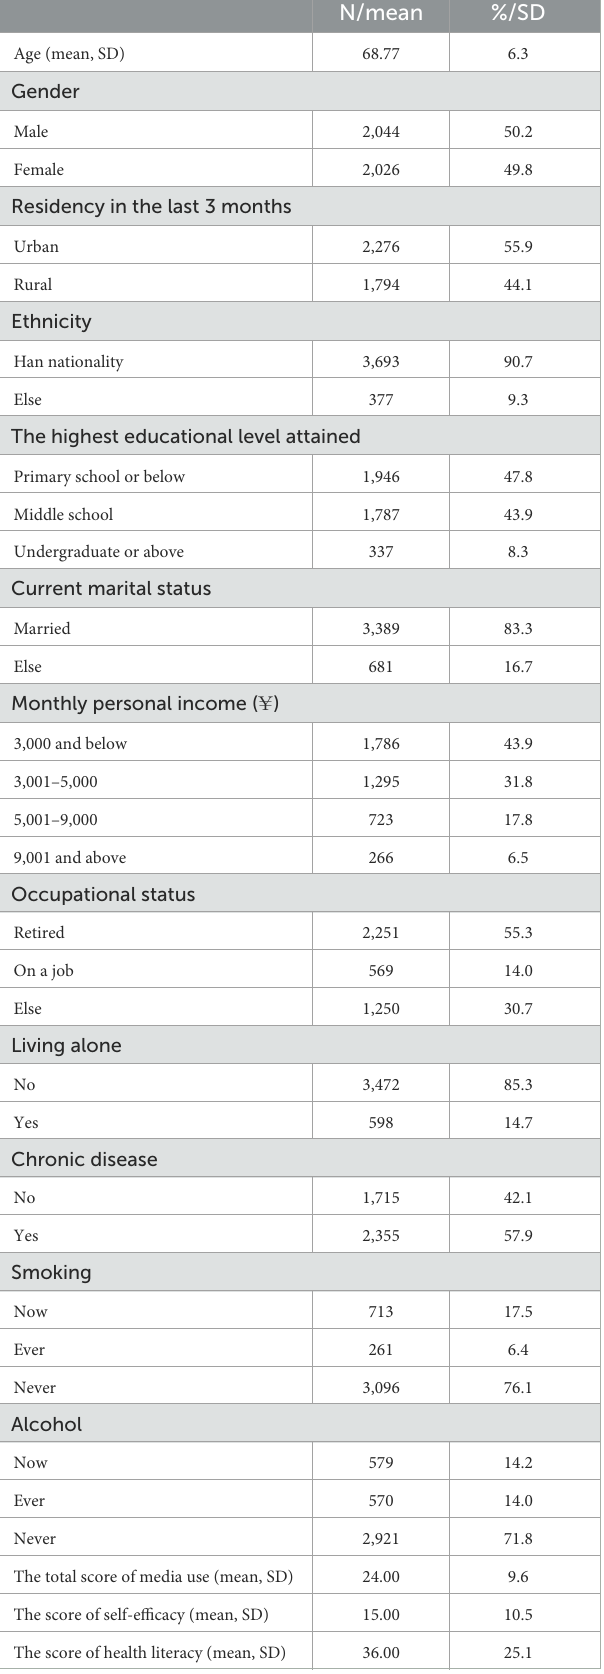
TABLE 1 Descriptive analysis of background characteristics ( N =